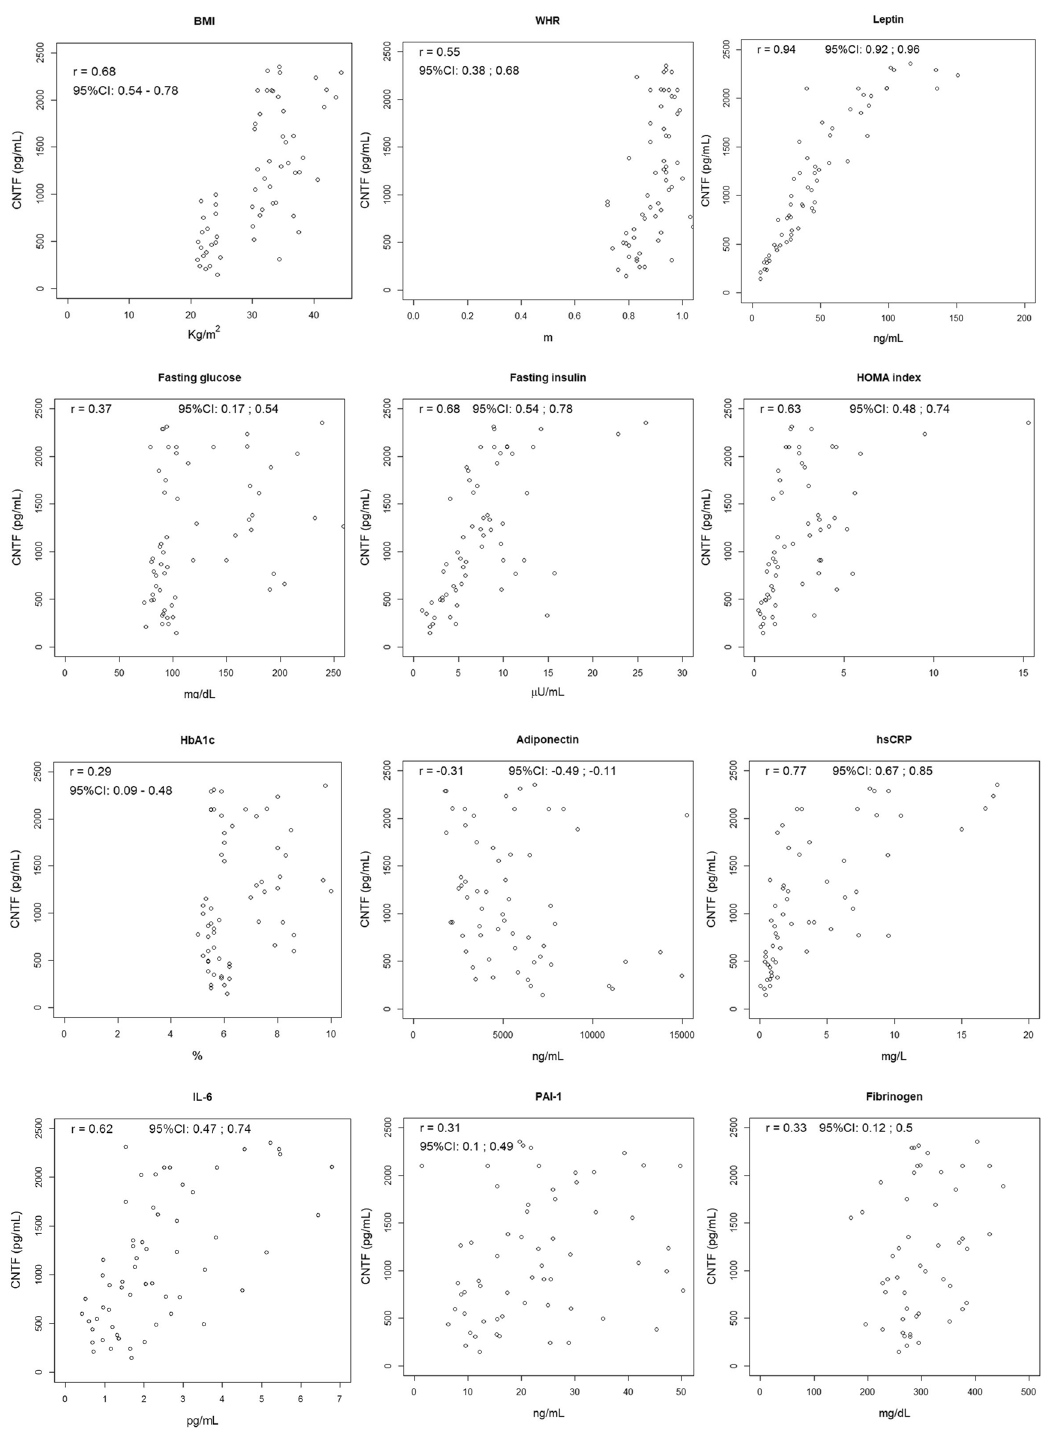
Figure 2. Correlation between plasma CNTF levels and clinical or haematological parameters of obesity, insulin resistance and inflammation in female subjects. Spearman correlation coefficients and 95%